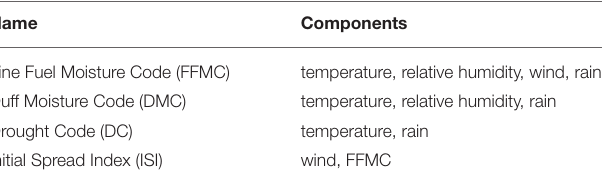
TABLE 2 | Codes of the FWI with their base components from the weather data according to [ 28].